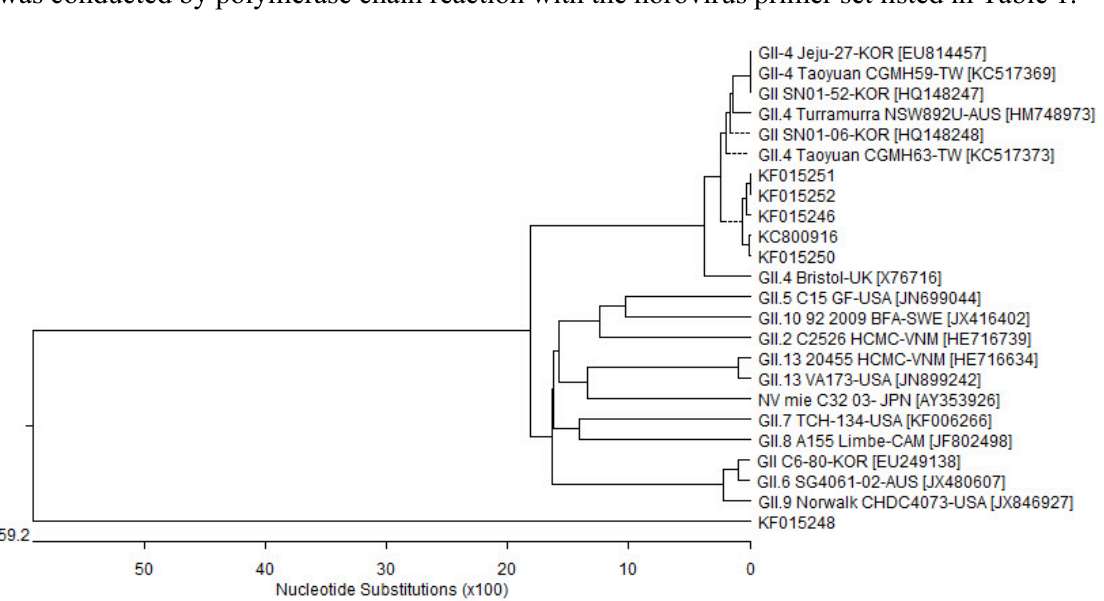
Figure 2. Phylogenetic tree of capsid genes in viruses. The phylogenetic tree was made using the partial sequence of the capsid gene, which was detected in norovirus GII. The detection was conducted by polymerase chain reaction with the norovirus primer set listed in Table